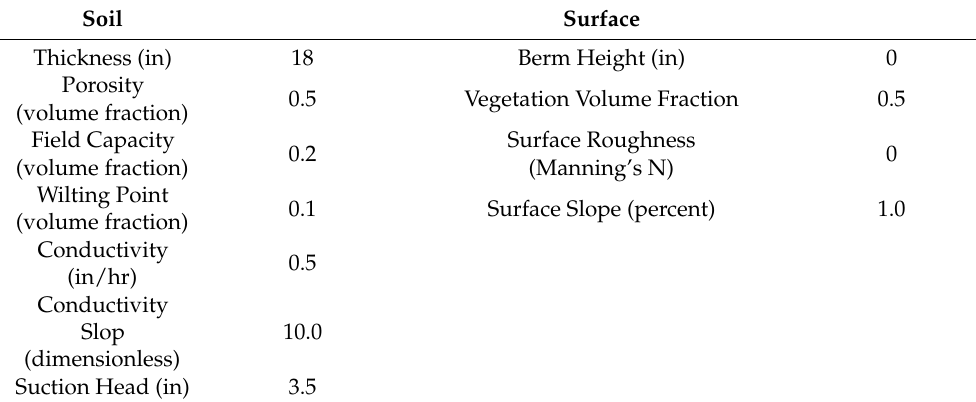
Table 1. Parameters of the rain garden.